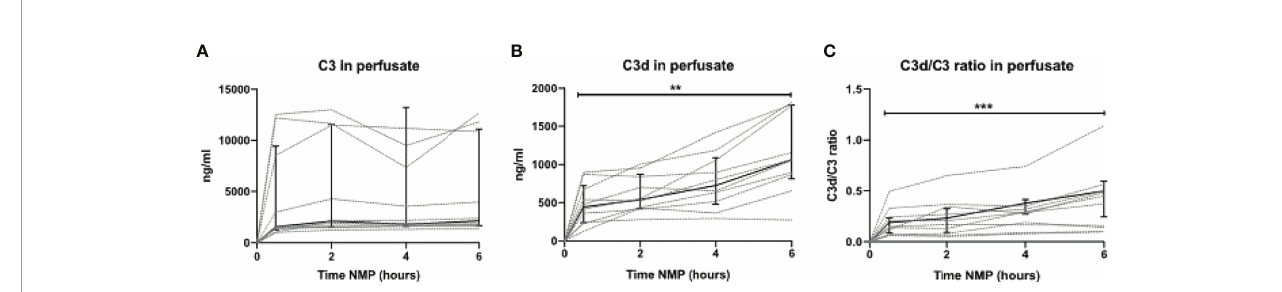
FIGURE 7 | Complement perfusate levels during normothermic machine perfusion of human discarded kidneys. (A) Complement C3 (in ng/ml) and (B) C3d levels (in ng/ml) and (C) the calculated C3d/C3 ratio in perfusate during 6 h of normothermic machine perfusion of human discarded kidneys. Dotted lines: increase of complement per individual kidney. Solid lines and bars: median ± interquartile range for all kidneys ( n = 10). ** p < 0.01, *** p < 0.001. NMP, normothermic machine perfusion.